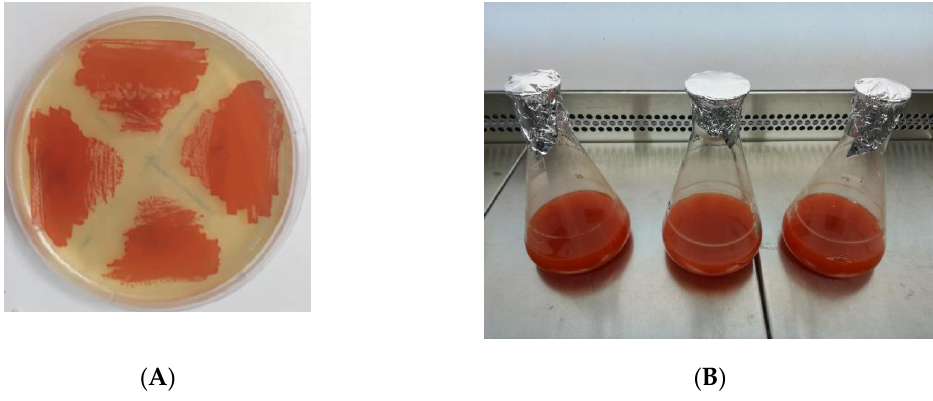
Figure 1. Orange-red haloarchaea colonies. ( A ) The colonies are orange in agar plates containing 25% ( w / v ) total salts ( B ) Culture liquid medium MH at 25% w / v , so the pigment culture changes to an intense red color after 72 h of incubation at 40 °C and 120 rpm.